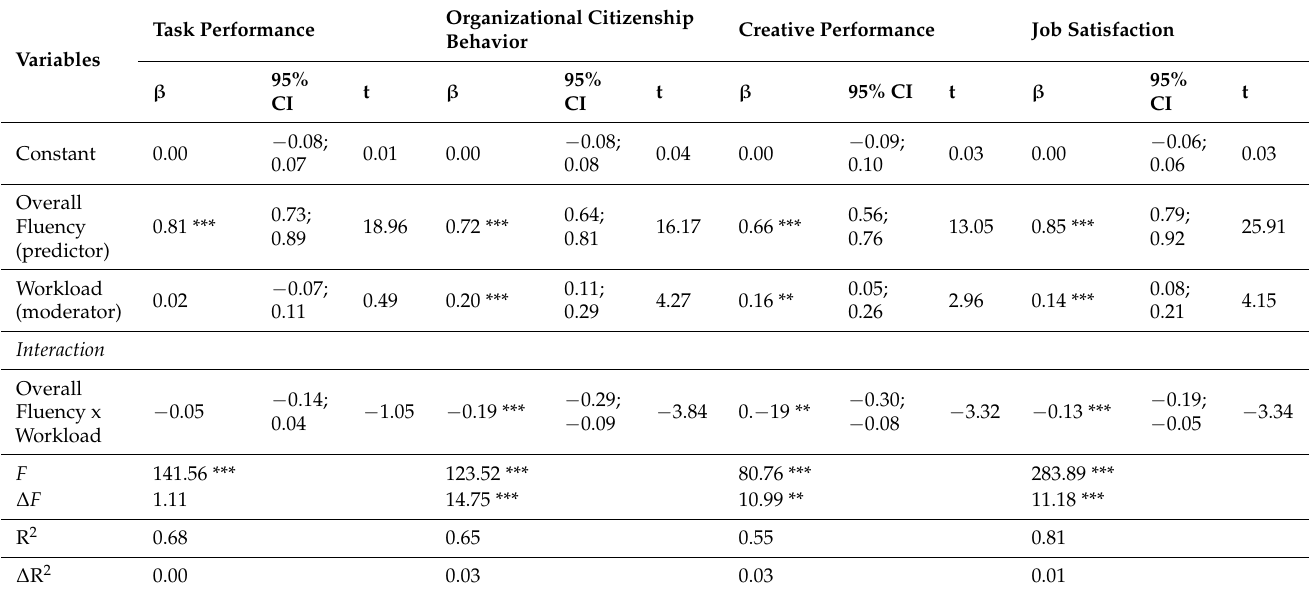
Table 4. Moderation analysis with overall fluency in human-robot interaction as a predictor, workload as a moderator, and task performance, organizational citizenship behavior, creative performance, and job satisfaction as dependent